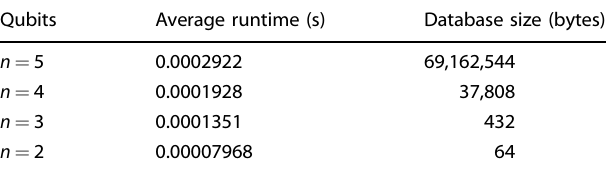
Fig. 2 Quantum advantage by Clifford circuits. An optimal CNOT gate circuit (left) can be implemented with fewer entangling gates as an optimal Clifford circuit (right). Table 2. Average runtime for optimally compiling n -qubit Clifford operators with the full database of reduced elements loaded into RAM. The runtime was measured on MacBook Pro laptop (early 2015 model) with Intel ® i7-5557U 3.1GHz CPU and 16GB